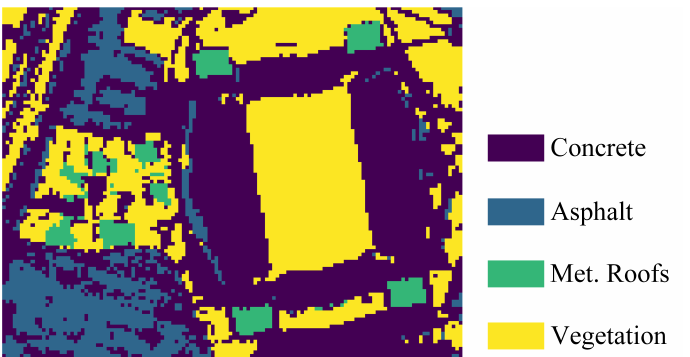
Figure 9. Ground truth of Houston